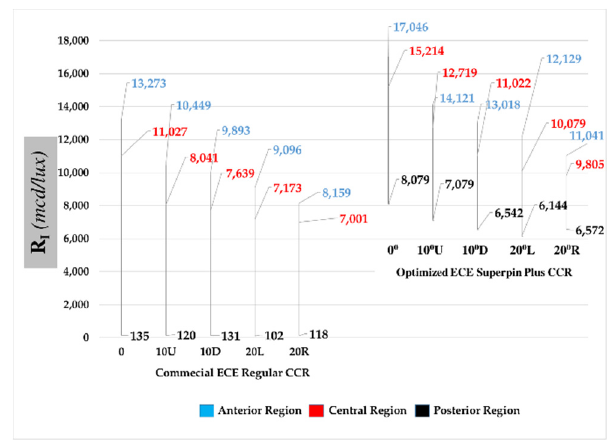
Figure 19. The intensity distributions on anterior, central, and posterior regions, which are shown in: